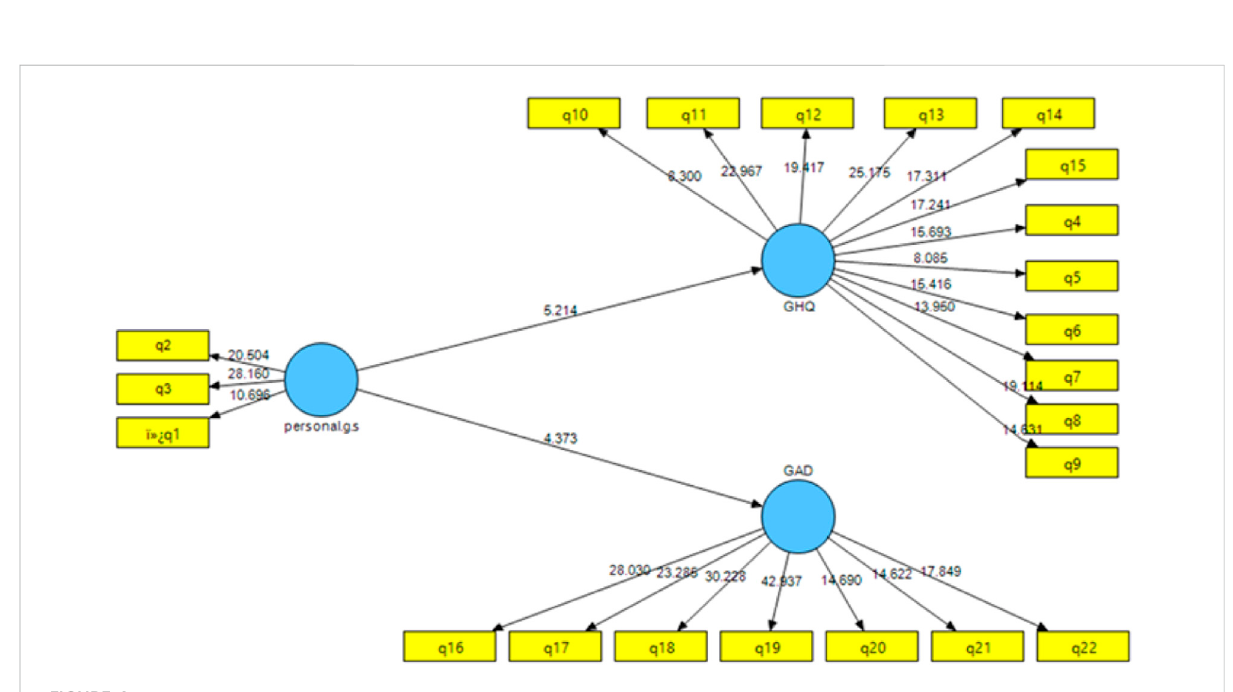
FIGURE 4 Signi fi cance level of the path in the structural